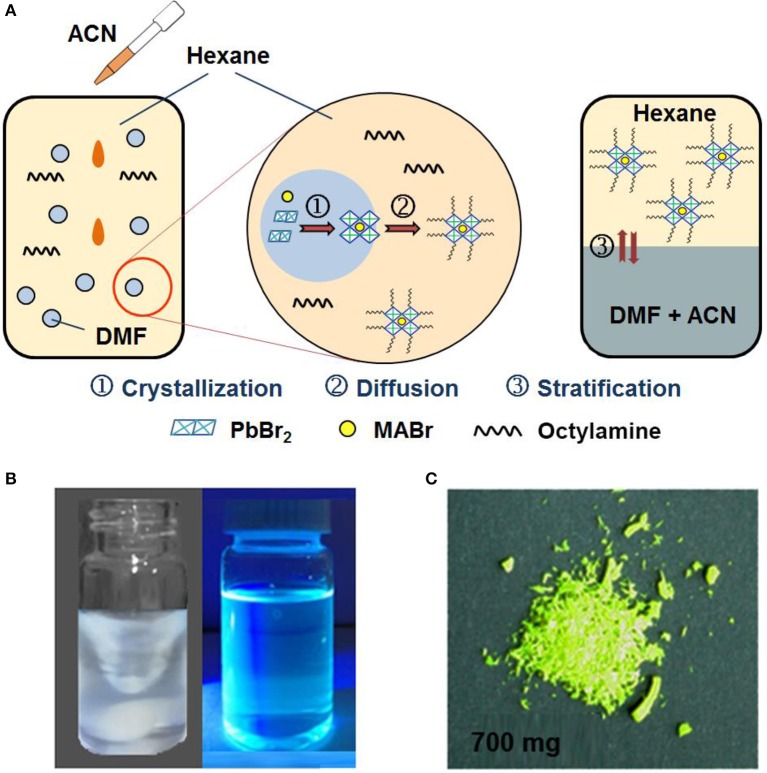
(A) Schematically illustration of the modified emulsion synthesis process with phase transfer strategy. (B) Optical photographs of the established emulsion system after addition of ACN (left) and obtained CH3NH3PbBr3 QDs dissolved in hexane under UV 365 nm radiation. (C) Optical photograph of resultant CH3NH3PbBr3 QDs powder in one pot synthesis.